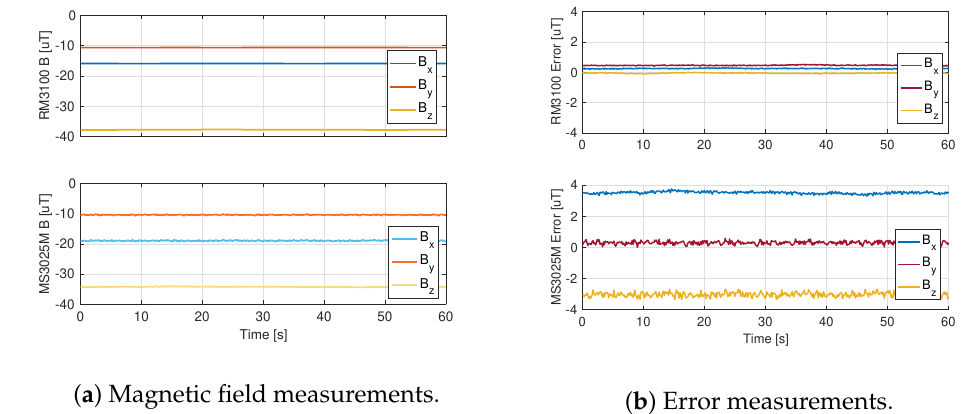
Figure 11. RM3100 and MS3025M magnetometer